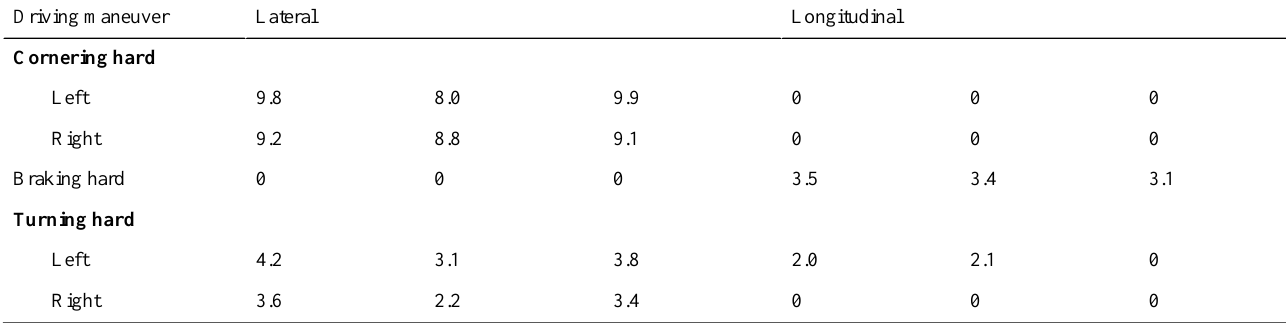
Table 2. Average duration of the g-force events over 0.45 g threshold